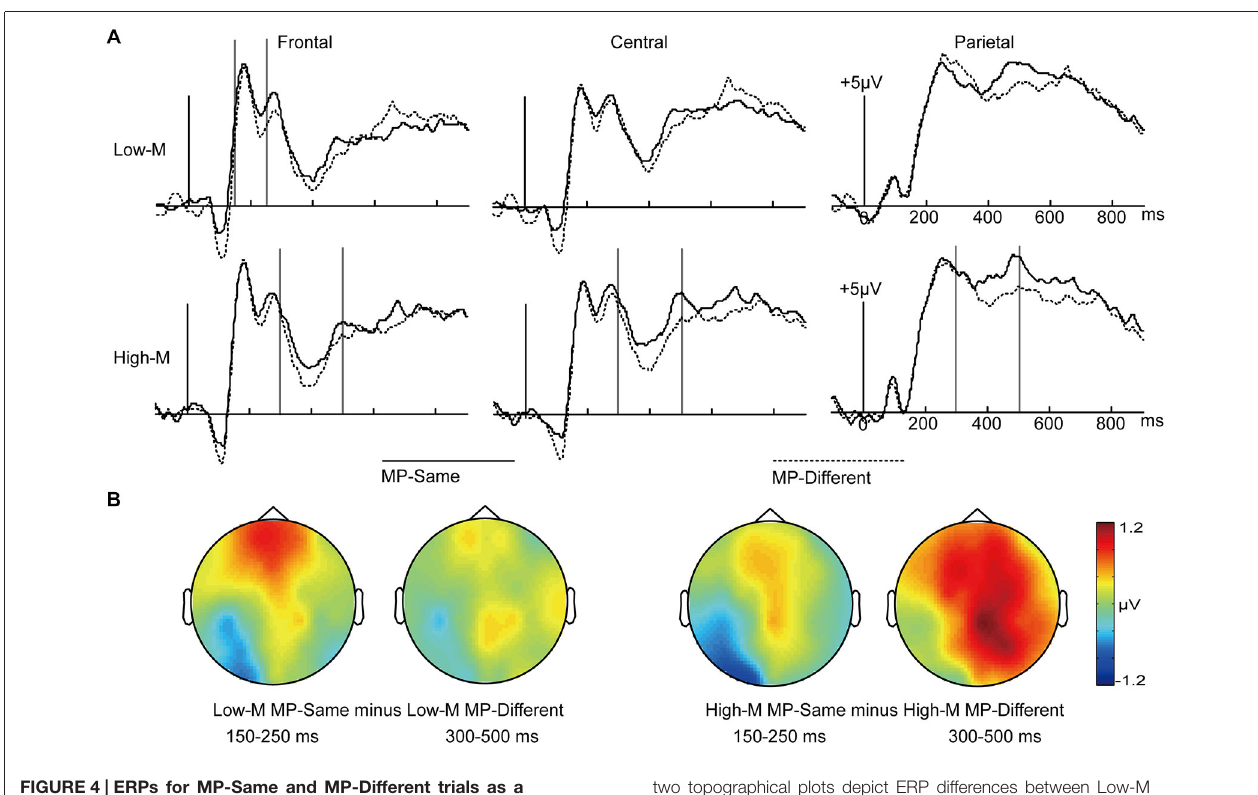
FIGURE 4 | ERPs for MP-Same and MP-Different trials as a function of High-M and Low-M. (A) Waveforms are shown from midline frontal electrodes to parietal electrodes. Gray vertical lines indicate the significant time windows (150–250 ms and 300–500 ms). (B) The left